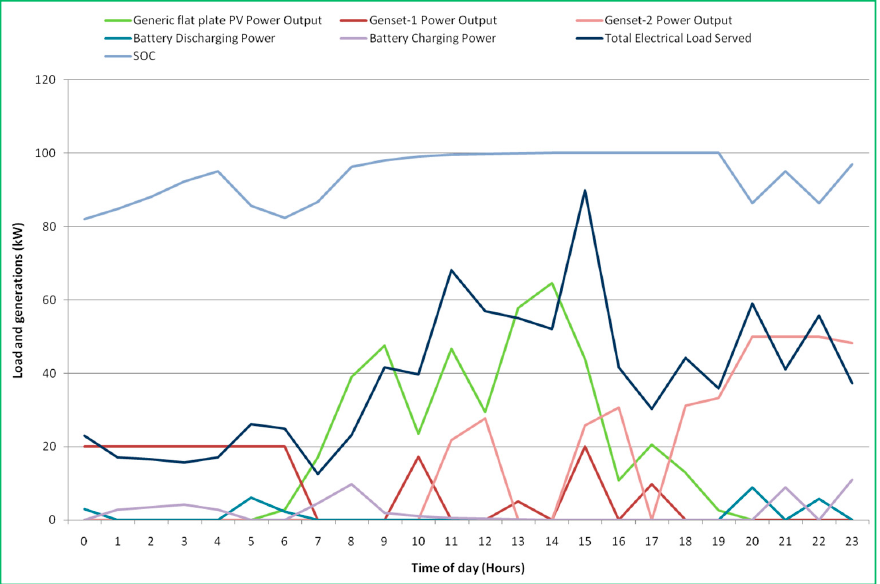
Figure 11. Rainy day without irrigation load for Case-2.